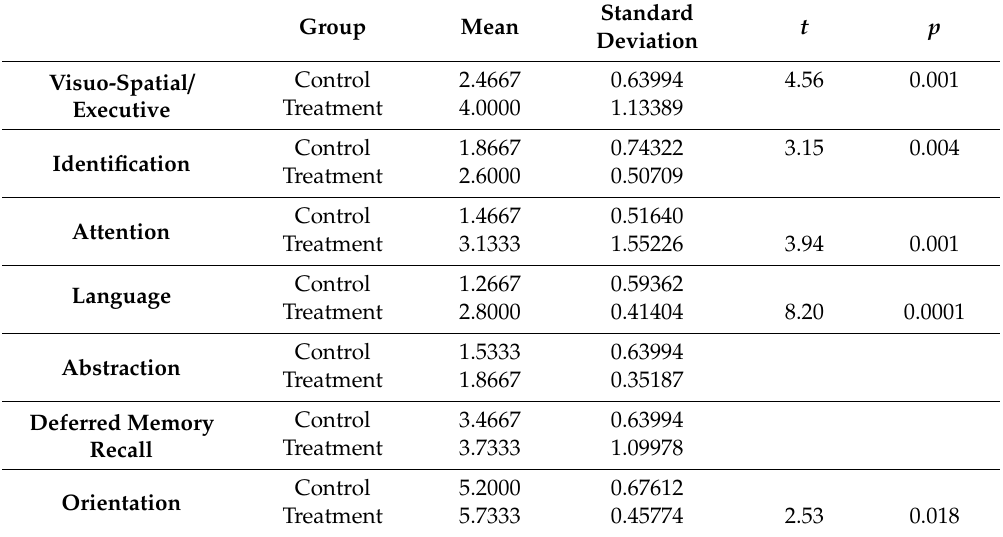
Table 2. Effect of training in the different areas evaluated by MoCA in the treatment group compared to the control group.